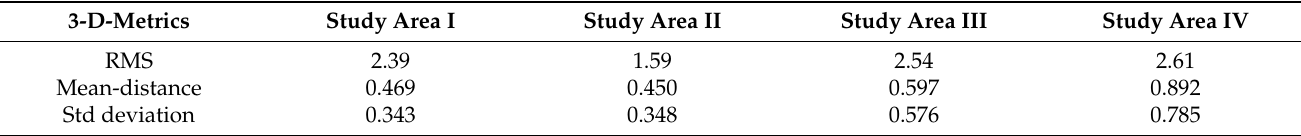
Table 2. Point to mesh registration results in the study area